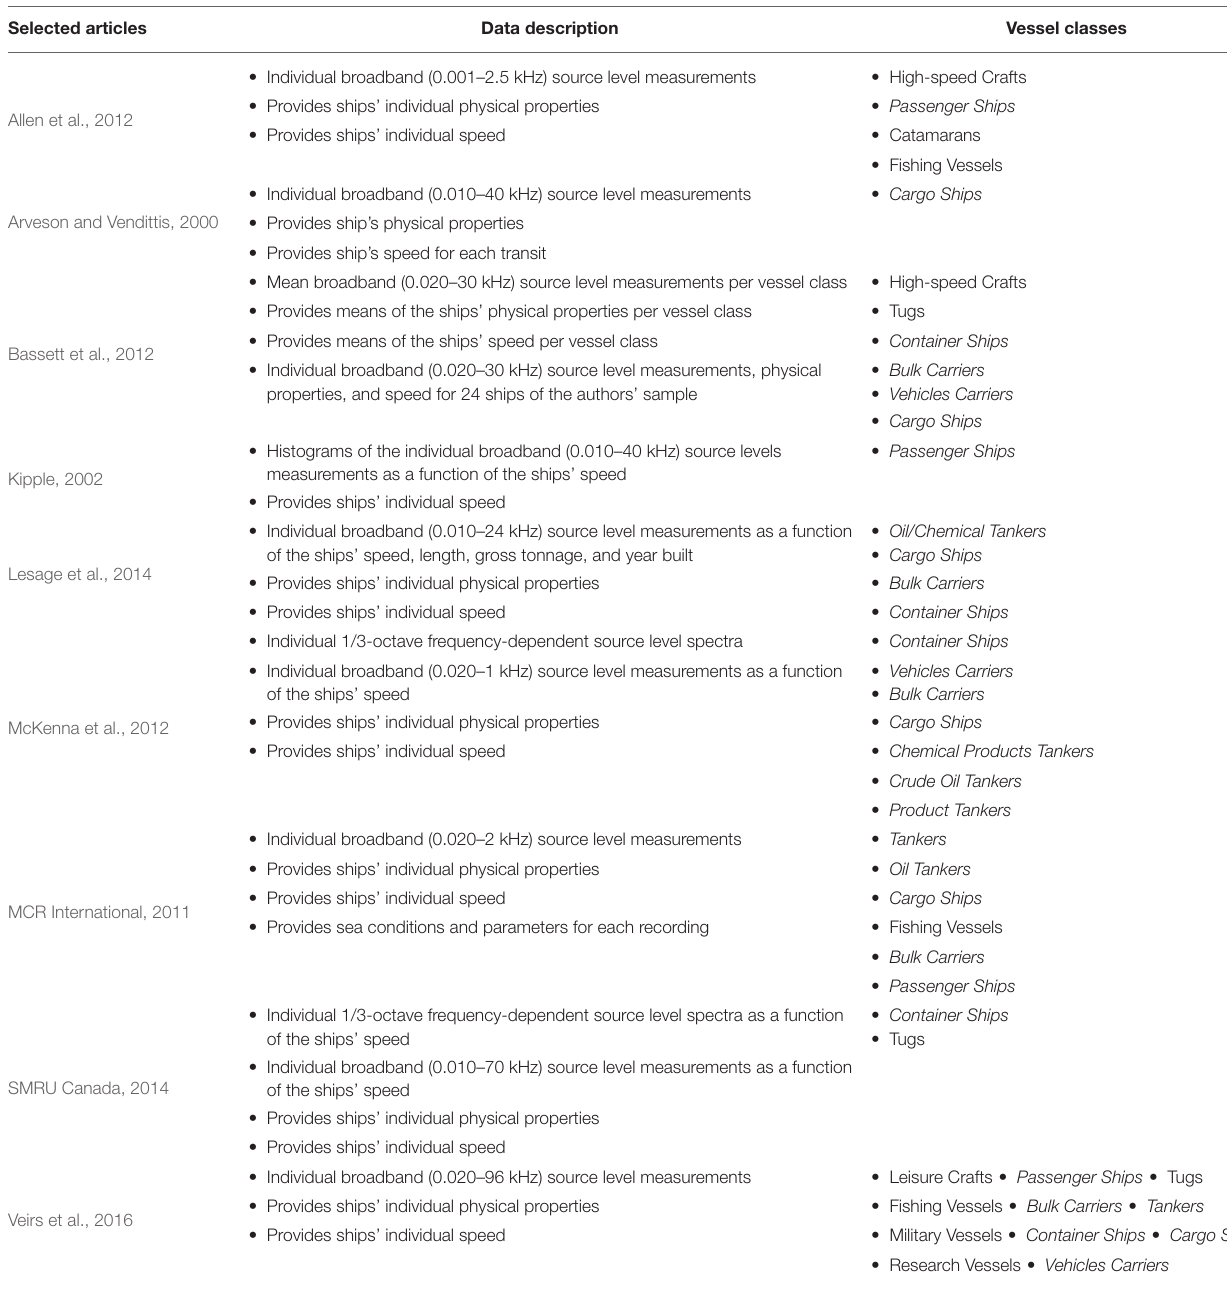
TABLE 2 | Details of the Observational Results. Selected